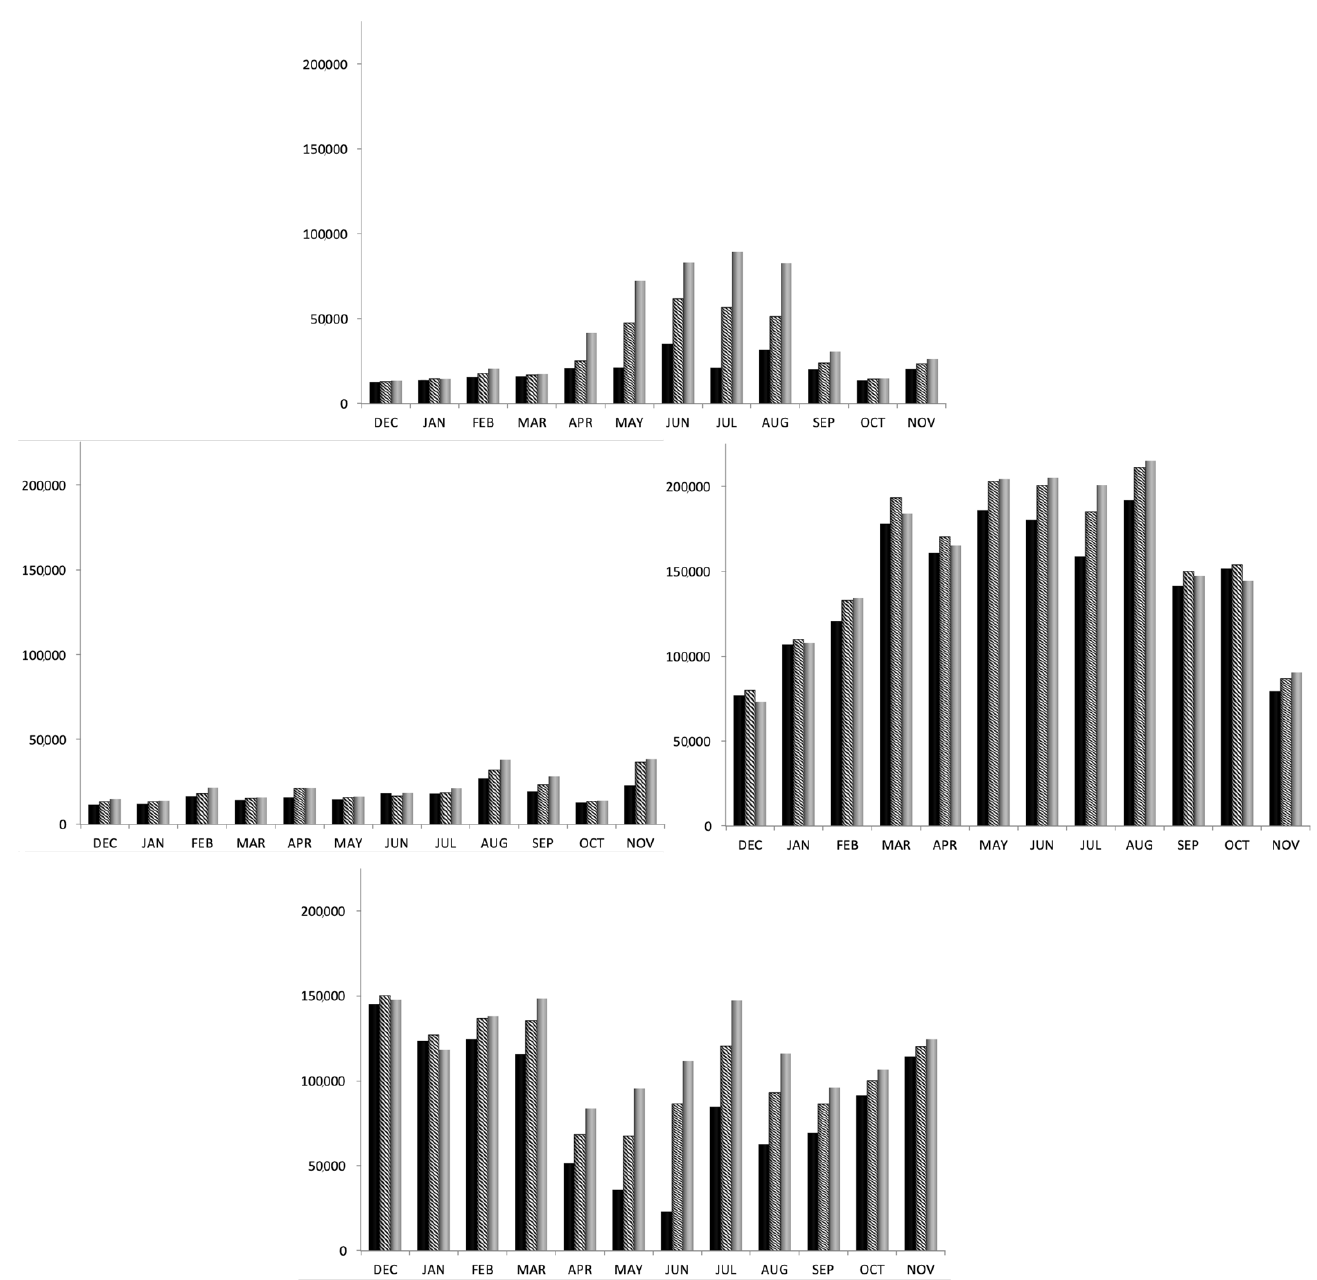
Figure 8. CL A values calculated depending on the season (from December 2018 to November 2019); orientation of north ( top ), east ( right ), south ( bottom ), and west ( left ); and elevation from the horizontal level of 15° (black), 30° (striped), and 45° (grey).